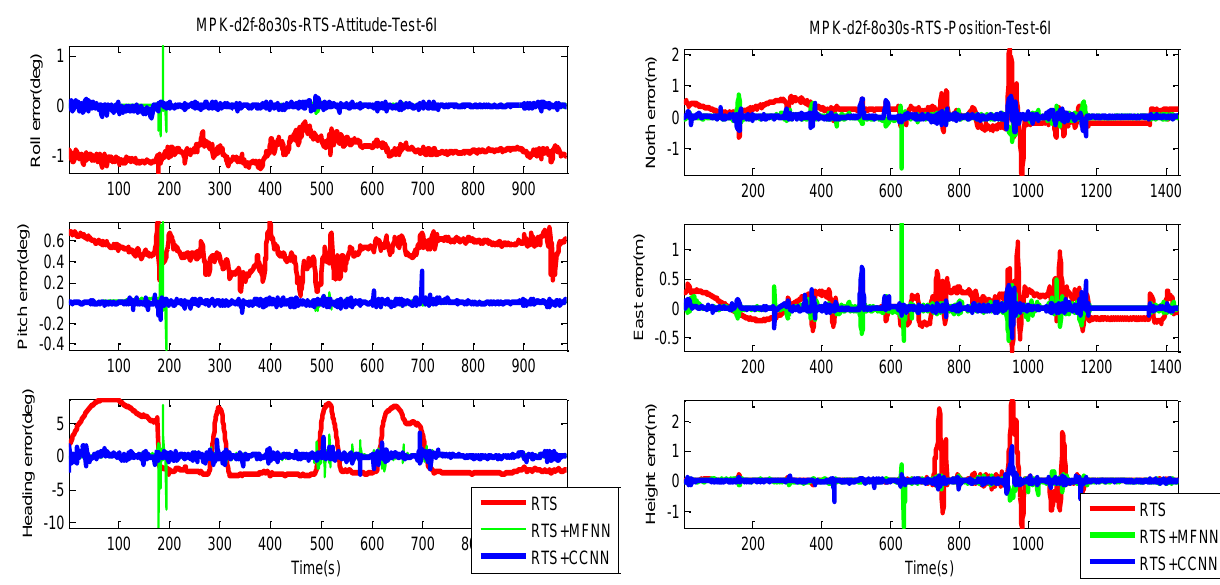
Figure 19. The samples of compensated positional and orientation errors (Testing scenario-I with